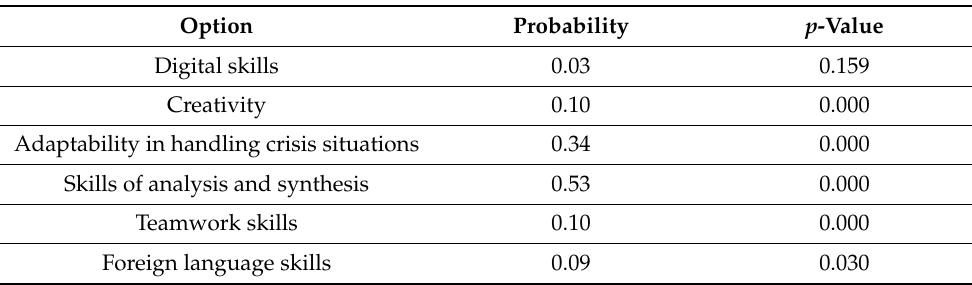
Table 5. Probabilities for each skill to require the biggest improvement knowing the importance assigned by